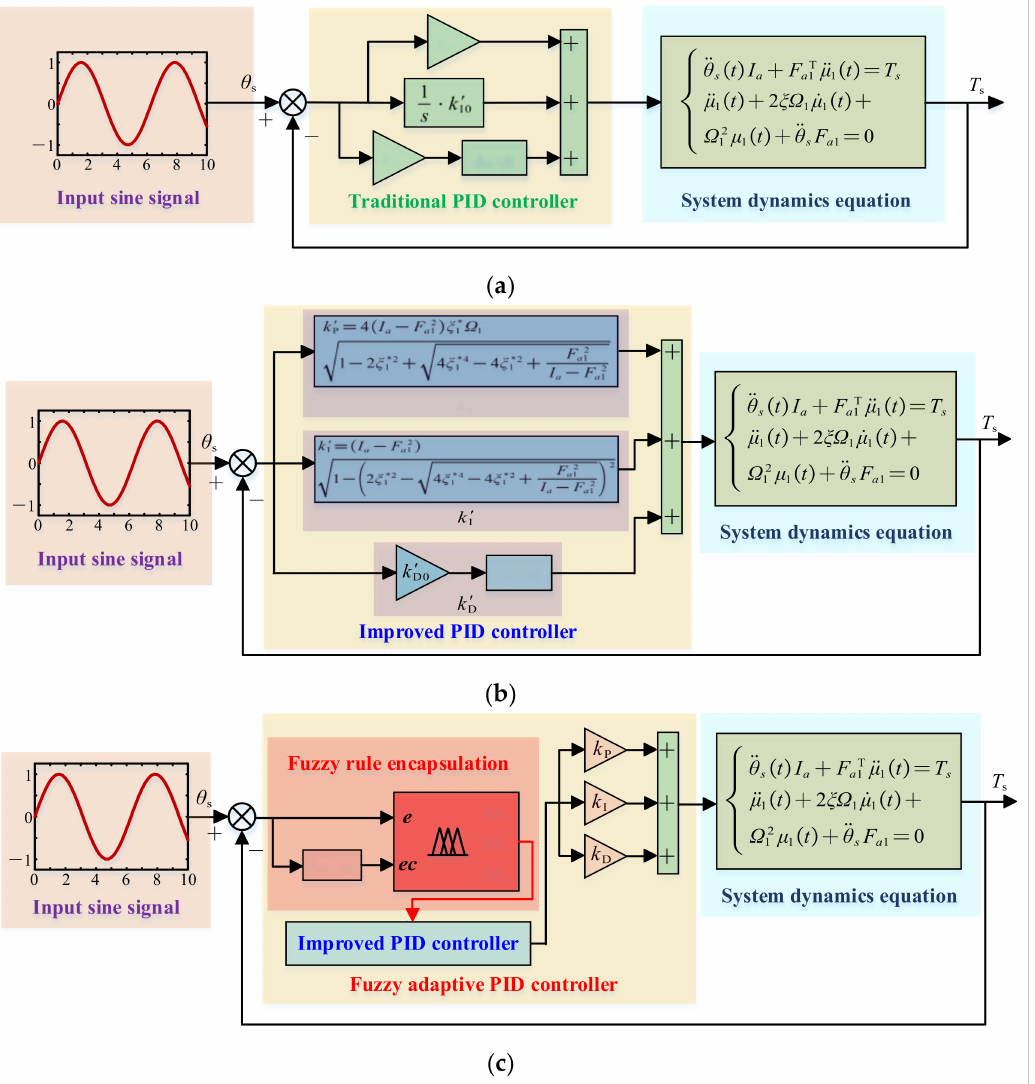
Figure 4. Control block diagram of a flexible-load servo system. ( a ) Block diagram of traditional PID control method. ( b ) Block diagram of pole assignment improved PID control method. ( c ) Block diagram of fuzzy adaptive PID control